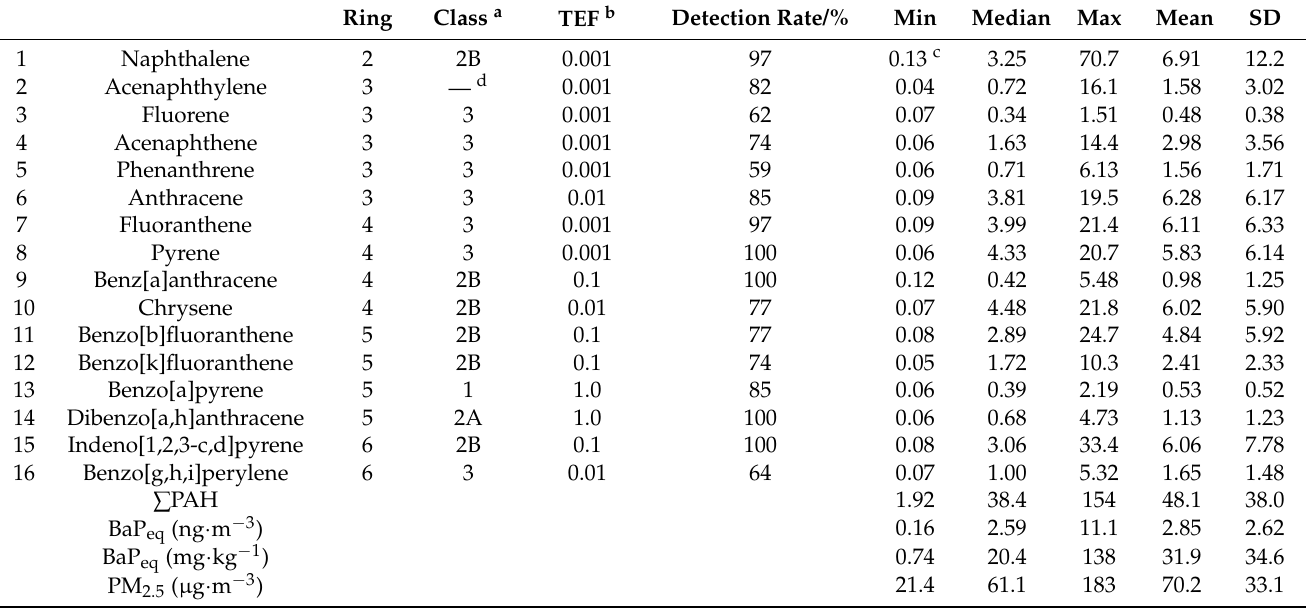
Table 2. Statistical description of polycyclic aromatic hydrocarbon (PAH) concentrations in PM